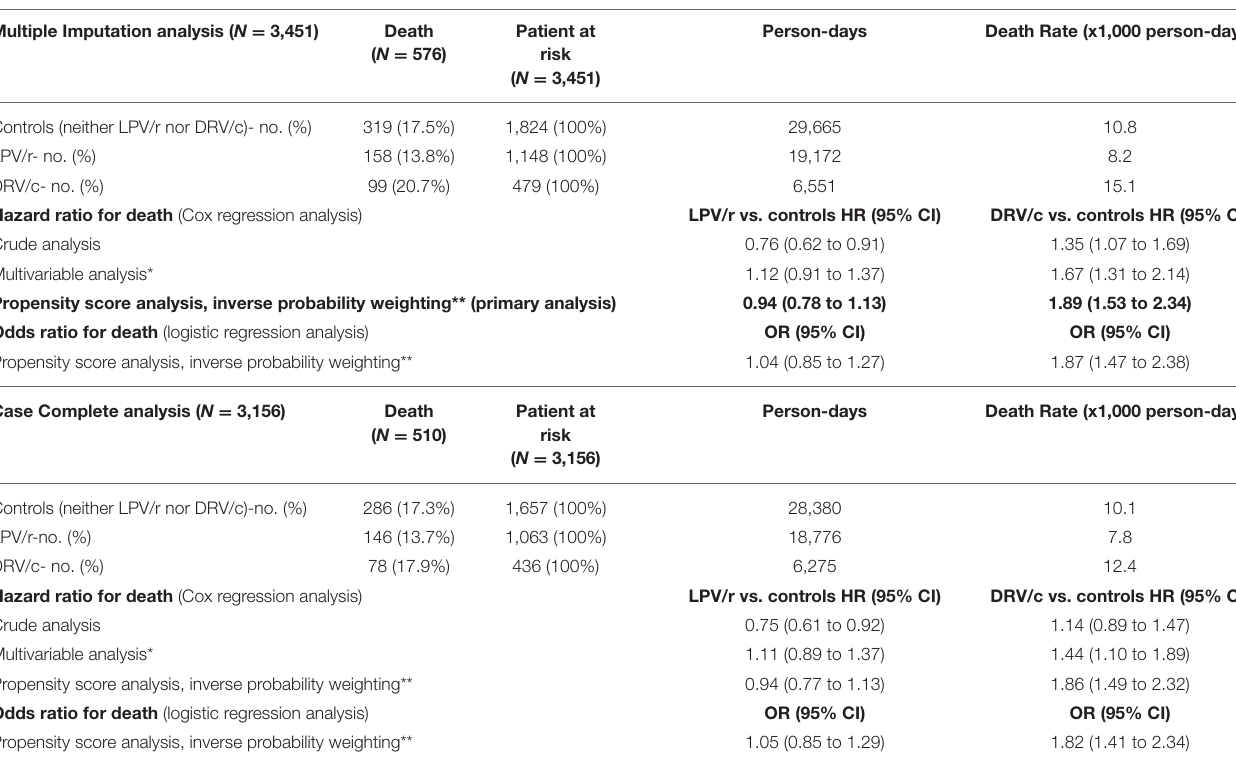
TABLE 2 | Incidence rates and hazard ratios for death in COVID-19 patients, according to lopinavir/ritonavir (LPV/r) or darunavir/cobicistat (DRV/c) use.